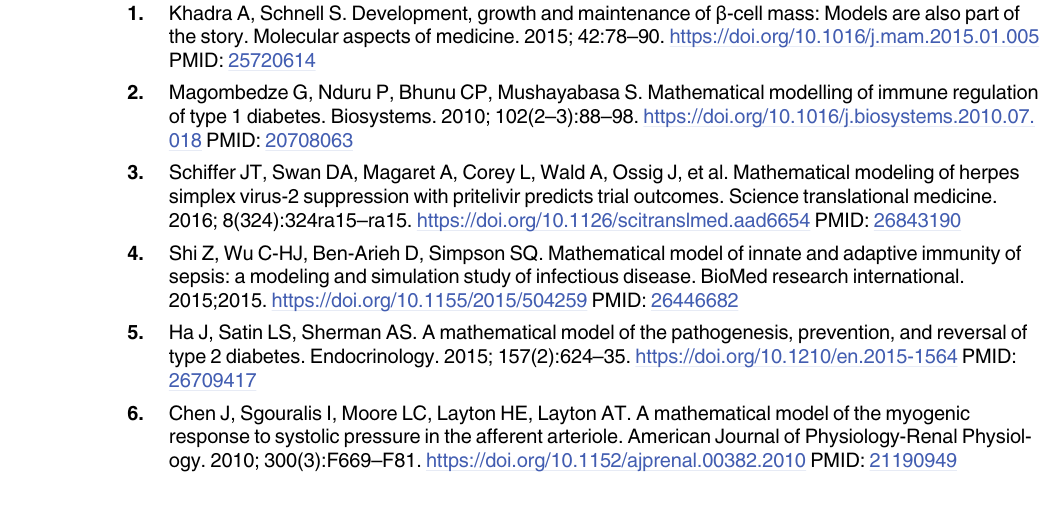
colors. Brown agents represent cytotoxic CD8+T cells, yellow for autoantigens, pink agents for activated CD8+T cells, and green agents turning black shaded areas show damaged and apo- ptotic beta-cells. Insulitis in NOD mice proceeds through a stage of peri-insulitis in which T cells accumulate around the islets. For improving the computational efficiency, the video only shows insulitis progressing from inside the islets.